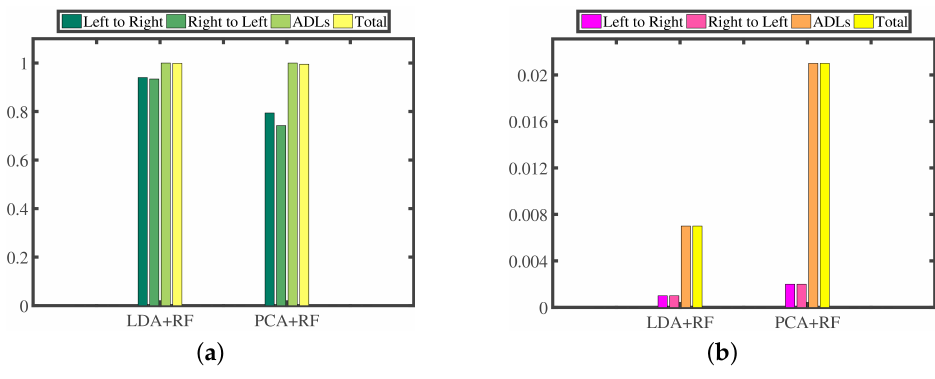
Figure 24. TPR ( a ) and FPR ( b ) of RF along with LDA and PCA.